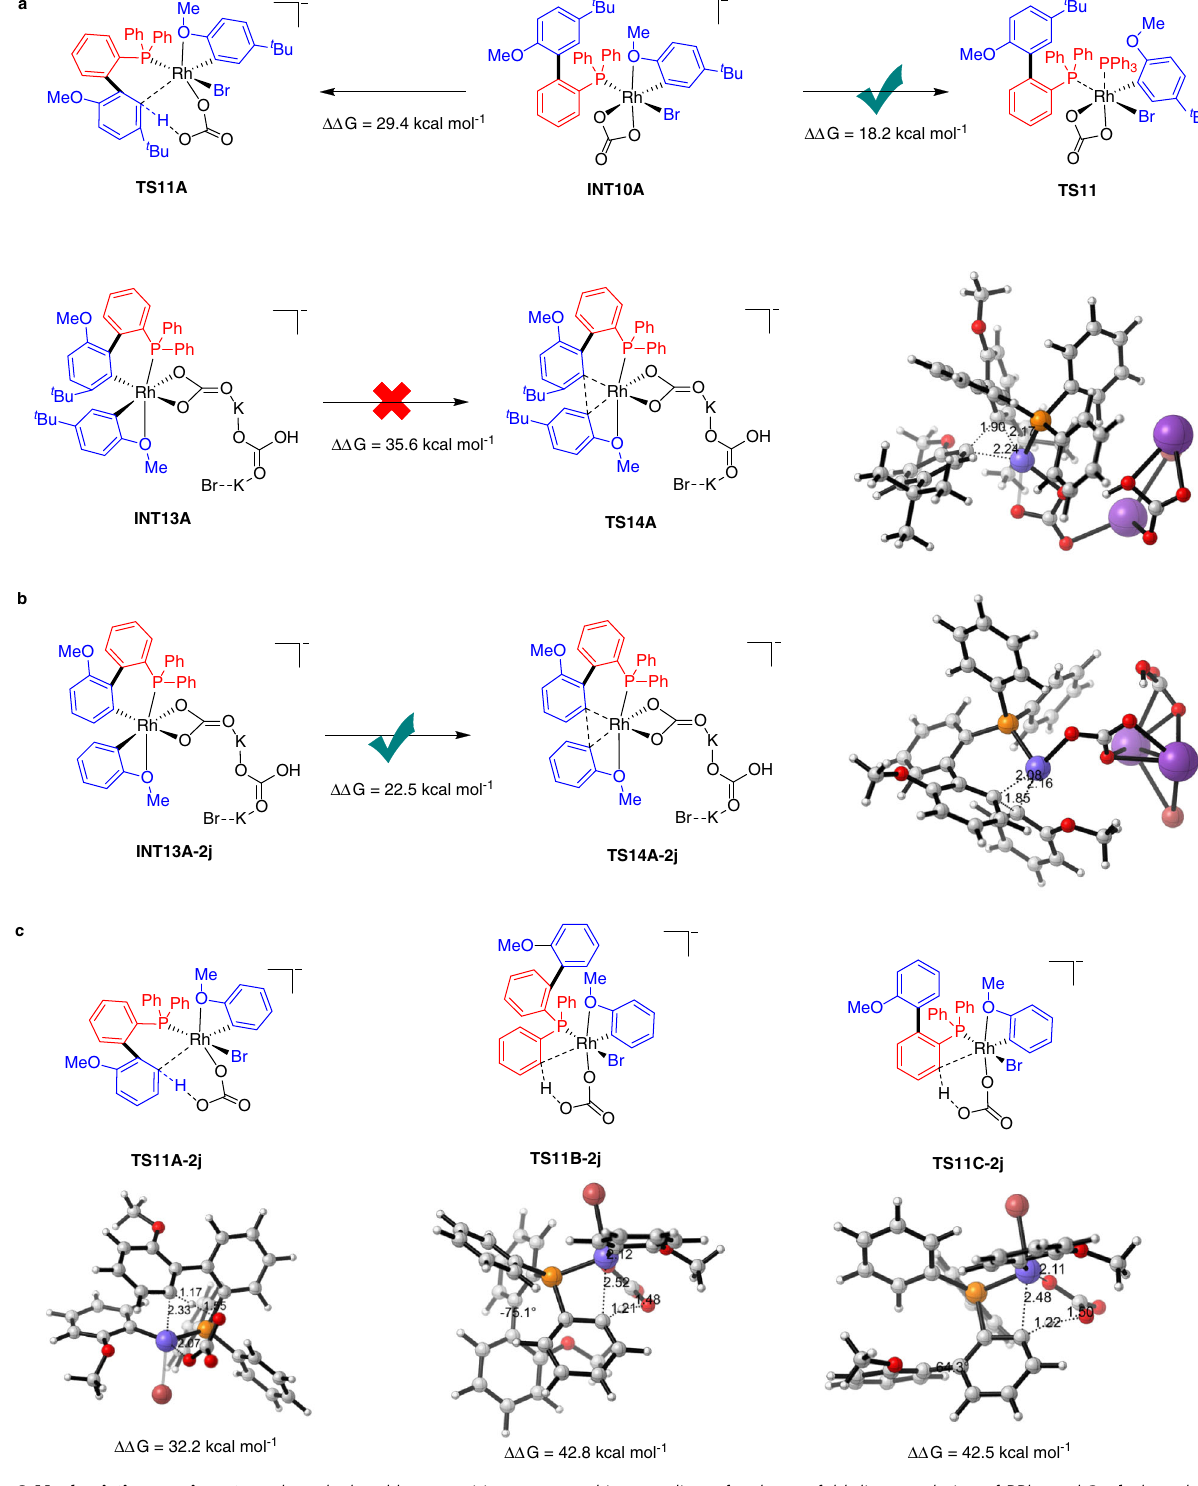
Fig. 8 Mechanistic experiments. a the calculated key transition states and intermediates for the twofold direct arylation of PPh 3 and 2a . b the calculated key transition states and intermediates for the twofold direct arylation of PPh 3 and 2j . c DFT-computed free energies for the three competitive C-H metalation pathways in the second-fold direct arylation of PPh 3 with 2j . Energies are in kcal mol − 1 and bond lengths are in